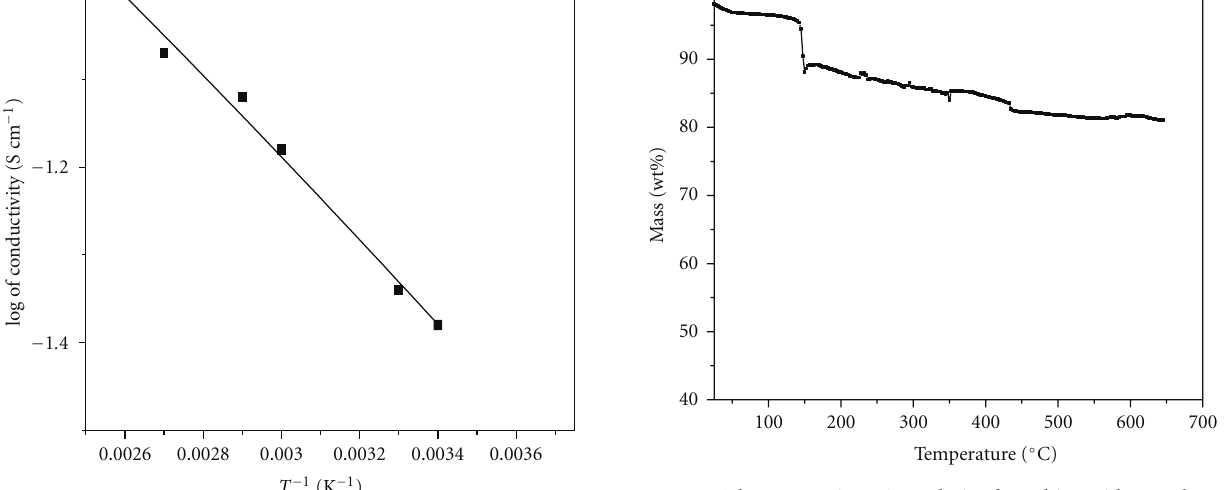
Figure 6: Thermogravimetric analysis of graphite oxide membrane over a temperature range of 25 to 650 ◦ C.